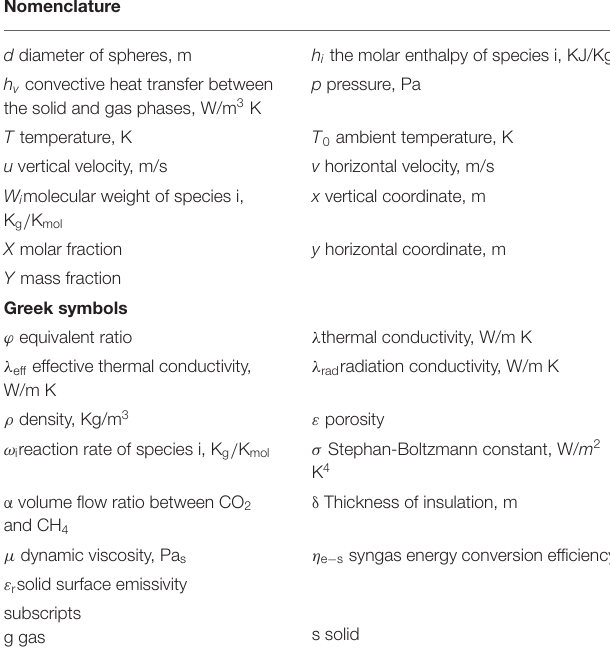
TABLE 1 | Symbols used in this work.